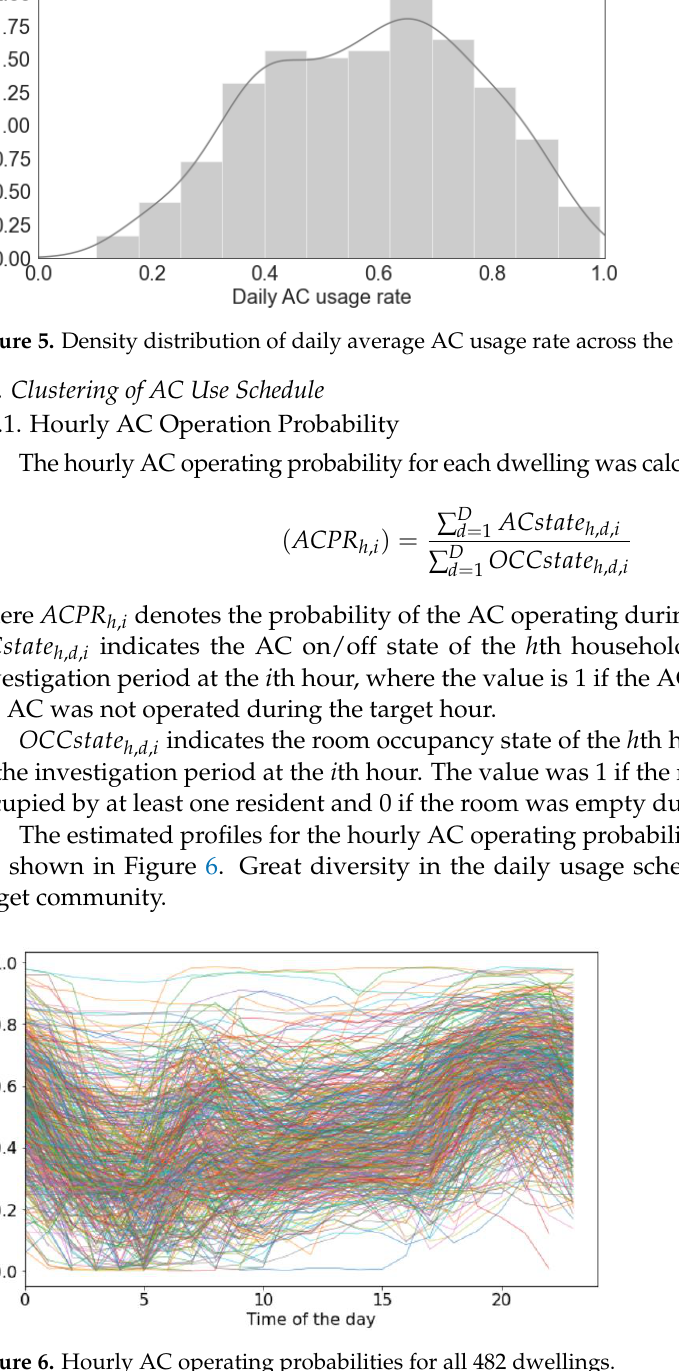
Figure 4. Scatter plot of average cooling hours and AC electricity consumption for each household per day.